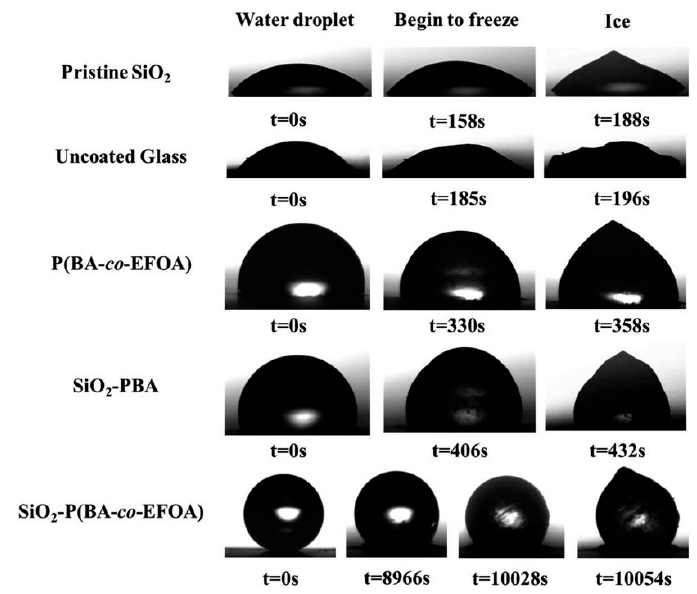
Figure 2. Photographs of individual water droplets on glass with different coatings during the whole freezing process captured by a high-speed CCD camera. Reproduced with permission from reference [85].